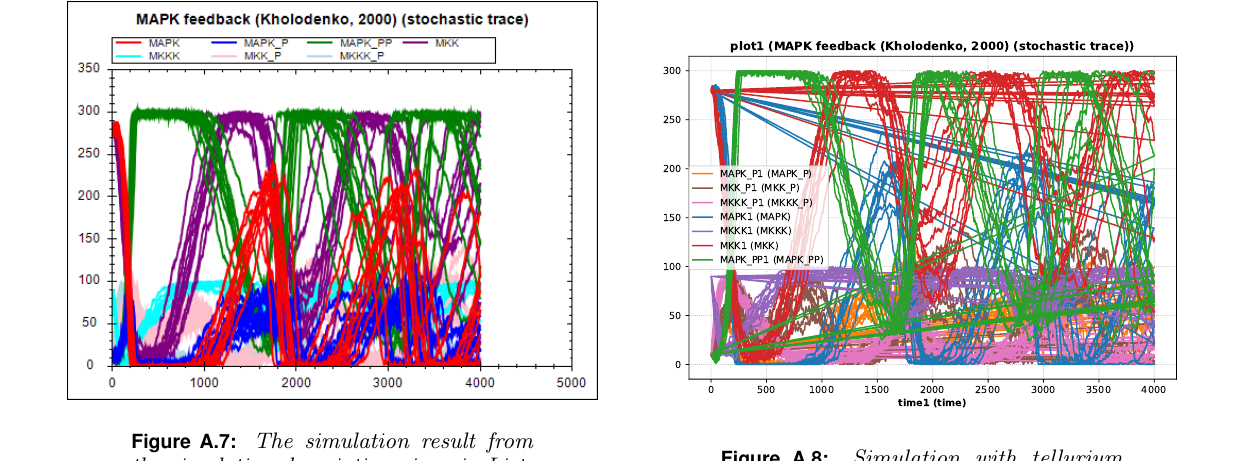
Figure A.8: Simulation with tellurium